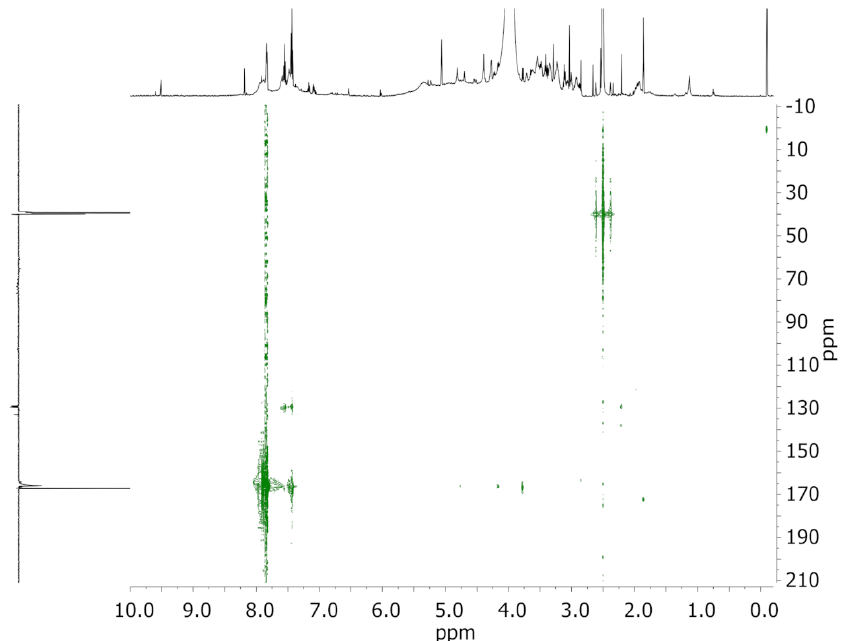
Figure 4. Gradient-selected 1 H, 13 C-HMBC NMR spectrum of benzoylated wood in DMSO- d 6 /LiCl (non-uniformly recorded with 10% NUS